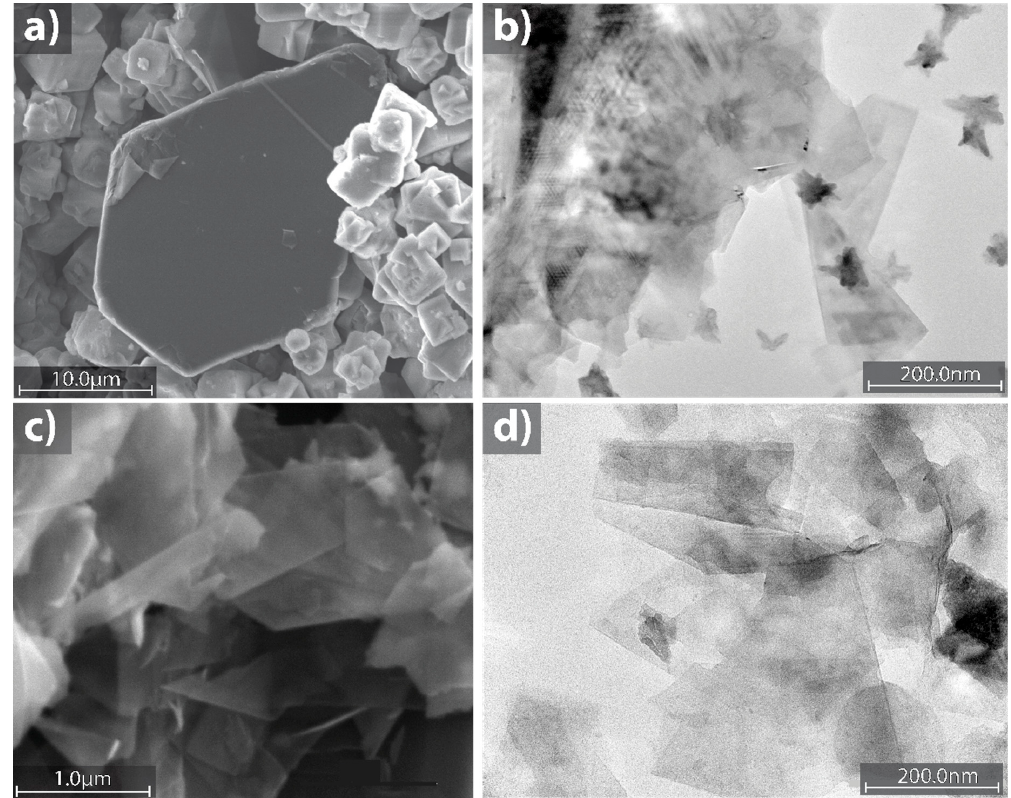
Figure 3. Microscopic analysis after zeolite-assisted shear exfoliation. SEM morphology of ( a ) non-exfoliated graphite flake interacting with Z4A, recovered as a precipitate and ( c ) Semitransparent layers obtained from supernatant in NMP+Z4A. TEM image of graphene nanosheets produced ( b ) by shear exfoliation without Z4A and ( d ) by zeolite-assisted shear exfoliation.